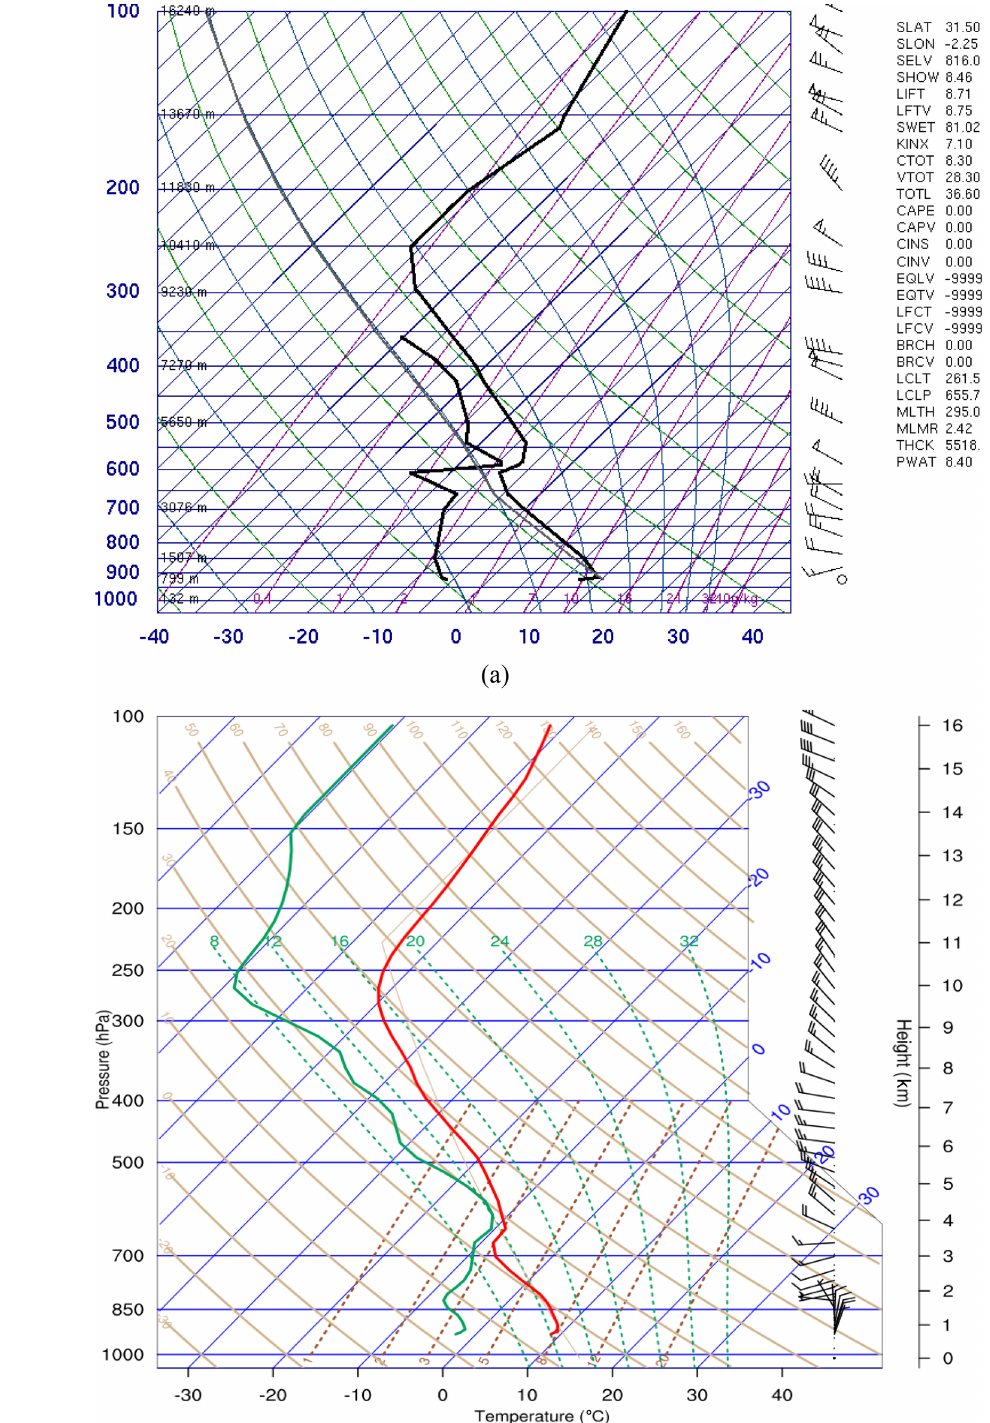
Figure 4. (a) Atmospheric soundings at 00:00UTC 2 March 2004 at Bechar in Algeria (source: University of Wyoming). (b) Atmospheric soundings at 00:00UTC 2 March 2004 at Bechar in Algeria plotted from WRF simulation (6km resolution).